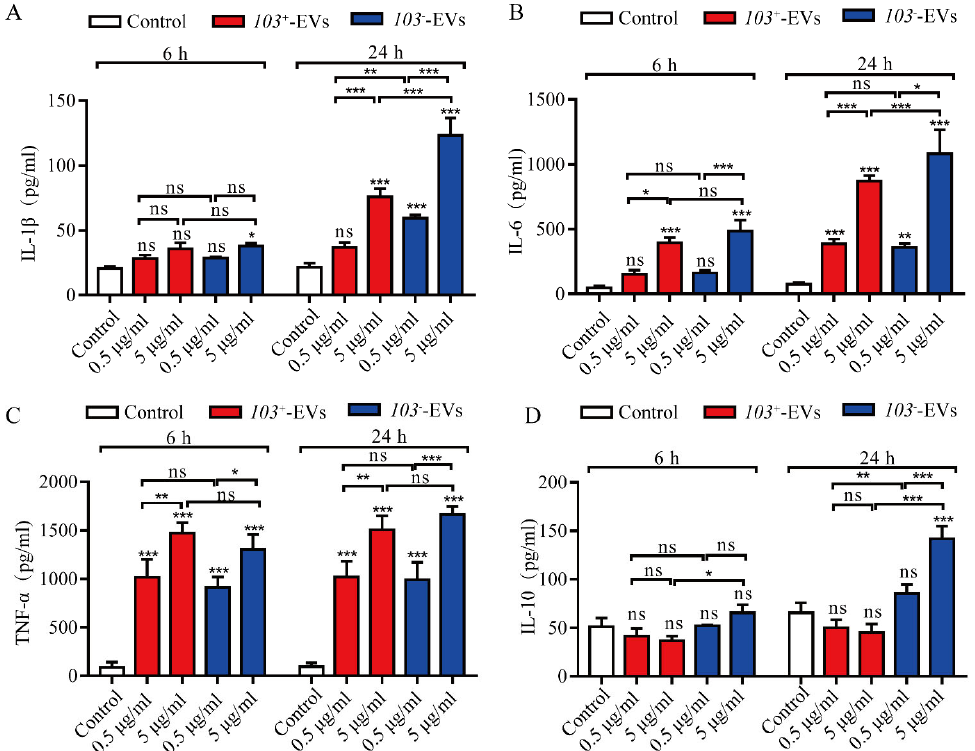
Figure 4. The 103 + ‐ EVs and 103 − ‐ EVs activate inflammatory responses in J774A.1 cells. The concen ‐ trations of ( A ) IL ‐ 1 β , ( B ) IL ‐ 6, ( C ) TNF ‐α , and ( D ) IL ‐ 10 in supernatants from J774A.1 cells. The supernatants from the J774A.1 cells stimulated with various concentrations of 103 + ‐ EVs or 103 − ‐ EVs for 6 h or 24 h were collected, and the inflammatory cytokines levels were measured by ELISA. The data were compared with the PBS stimulated control cells. The comparisons between groups were performed by one ‐ way ANOVA followed by Tukey’s test. * p < 0.05, ** p < 0.01, *** p < 0.001, and ns, not significant.